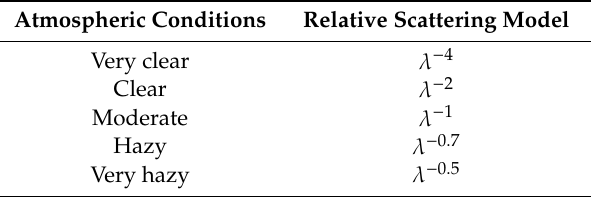
Table 2. Five relative scattering models [47].